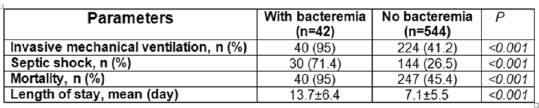
Table I: Outcome comparison according to